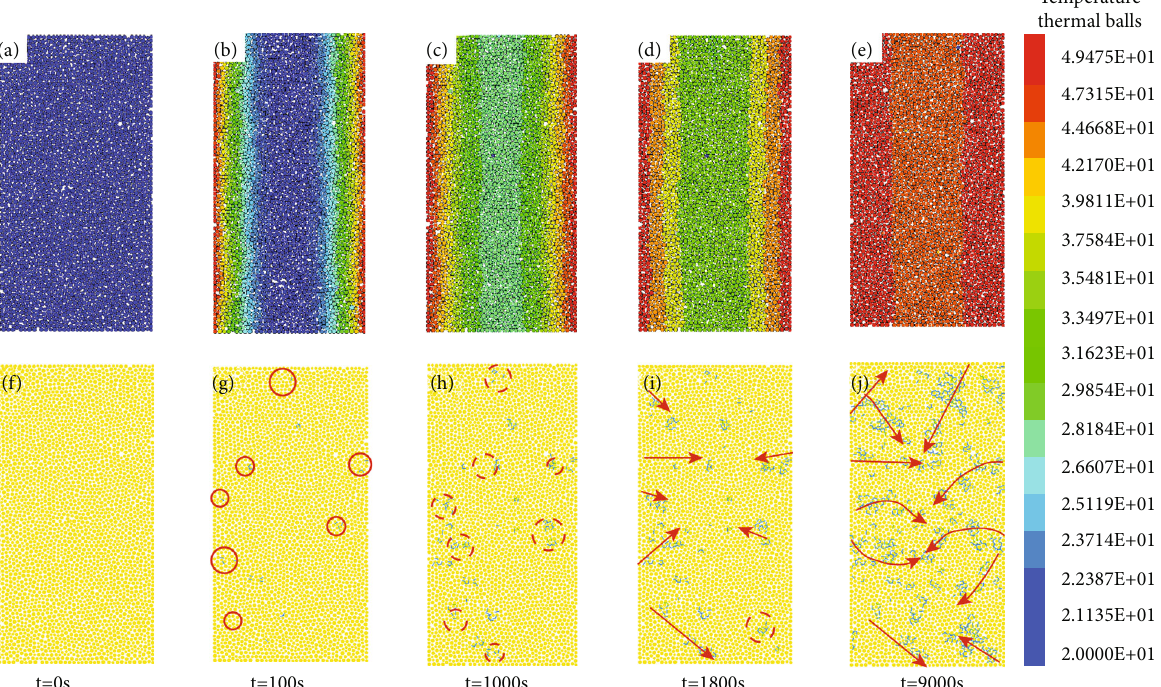
Figure 10: Distribution and propagation of cementation failure points in the salt rock model at 50 ° C (blue is the tensile failure points, green is the shear failure points, and red arrow represents the microcrack propagation direction).